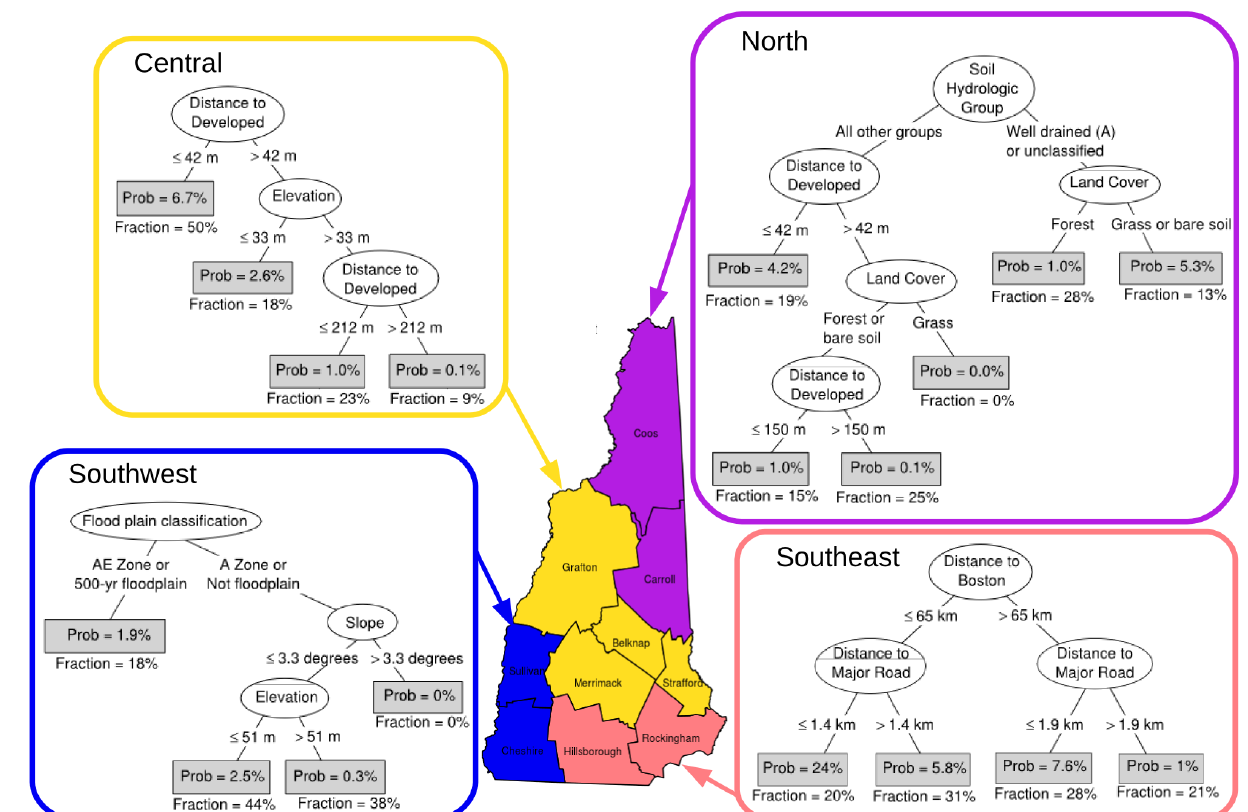
Fig. A2.2. Example regression trees (RTs) for development in regions of New Hampshire.